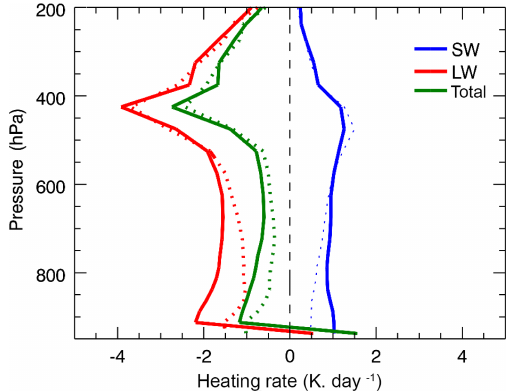
Figure 14. Atmospheric heating rate profile for selected dry days (11, 12, and 16 June; dashed lines) and moist days (18, 19, and 25 June; solid